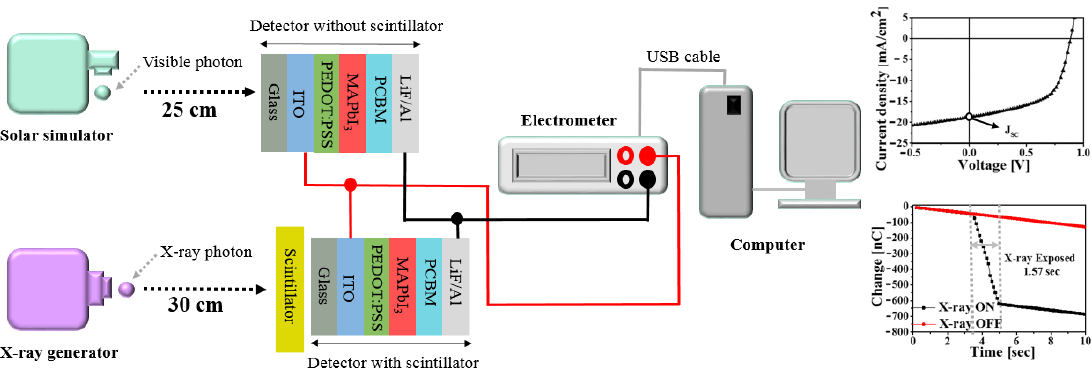
Figure 4. Schematic diagram of the experimental setup for measuring the parameters of the perovskite detector without and with the CsI(Tl) scintillator.